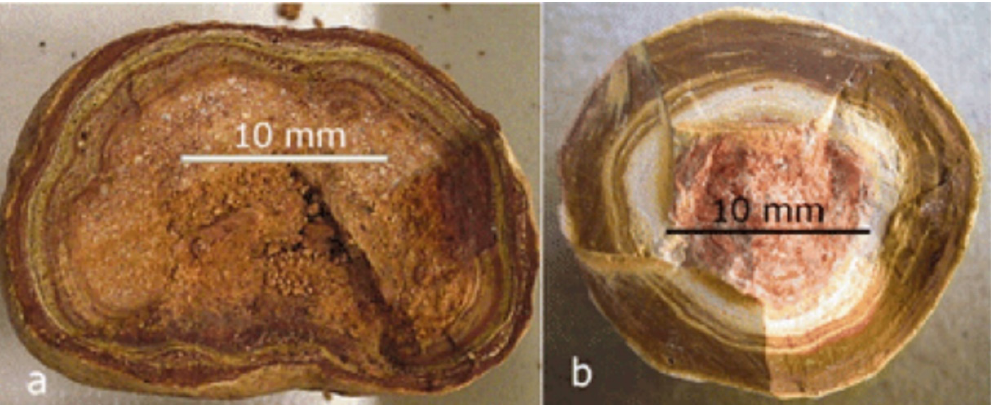
Figure 2. Two examples of pisoliths from the general region of interest. These images were reproduced from reference [24]. ( a ) a 25 mm nodule and ( b ) a 20 mm pisolith.